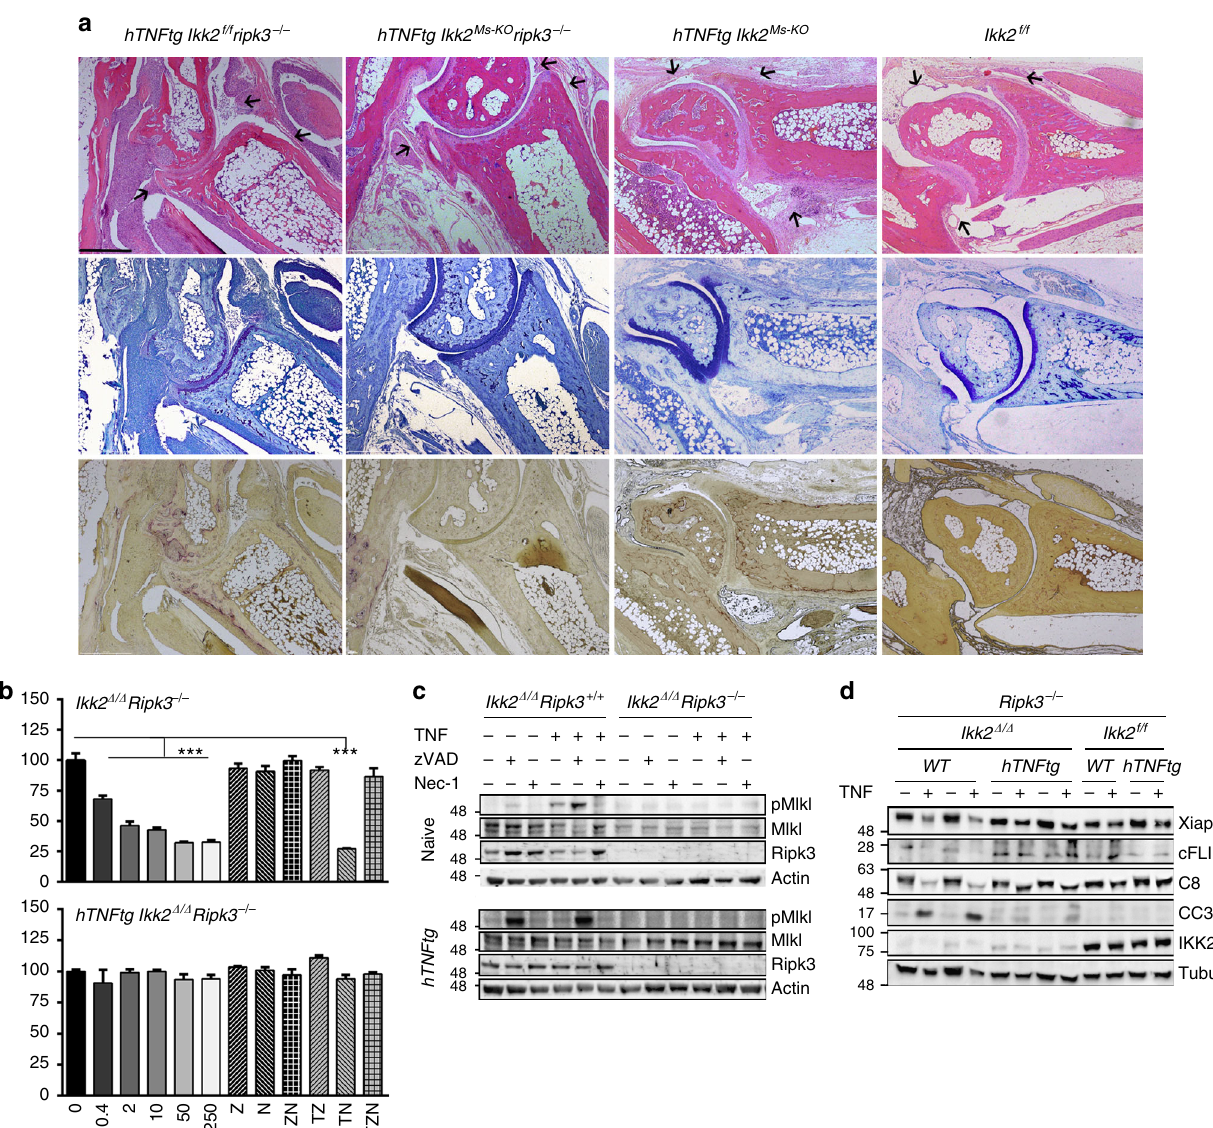
Fig. 5 Ripk3-mediated signals are indispensable for persisting synovitis in hTNFtg Ikk2 Ms-KO mice. a Representative histological images of H&E-, TB- and TRAP-stained ankle joint sections of 8-week-old hTNFtg Ikk2 f/f Ripk3 − / − ( n = 11) and hTNFtg Ikk2 Ms-KO Ripk3 − / − mice ( n = 13) in comparison to hTNFtg Ikk2 Ms-KO and Ikk2 f/f mice. Note the differences in synovium and adjacent tissues in respective areas indicated by the arrows. b Survival rates of Ikk2 Δ / Δ Ripk3 − / − and hTNFtg Ikk2 Δ / Δ Ripk3 − / − SF cultures treated with TNF (T), zVAD (Z), and nec-1 (N) as indicated. c Representative immunodetection of pMlkl, Mlkl and Ripk3 levels in the cell extracts of Ikk2 Δ / Δ Ripk3 − / − and hTNFtg Ikk2 Δ / Δ Ripk3 − / − SFs treated as indicated compared to control Ikk2 Δ / Δ Ripk3 + / + and hTNFtg Ikk2 Δ / Δ Ripk3 + / + samples, respectively ( n = 4 per genotype, 2 experiments). d Representative immunodetection of Casp8 (C8), Cleaved Casp3 (CC3), Xiap, cFLIP (s) and IKK2 levels in cell extracts of Ikk2 Δ / Δ Ripk3 − / − and hTNFtg Ikk2 Δ / Δ Ripk3 − / − SFs treated as indicated compared to control Ikk2 f/f Ripk3 − / − and hTNFtg Ikk2 f/f Ripk3 − / − samples, respectively (the non-hTNFtg control cultures are indicated as WT) ( n = 4 per genotype, 2 experiments). Scale bar: 500 μ m. Data are presented as the mean ± SEM. *** P < 0.001 one-way ANOVA test ( b ). Unprocessed original scans of blots are shown